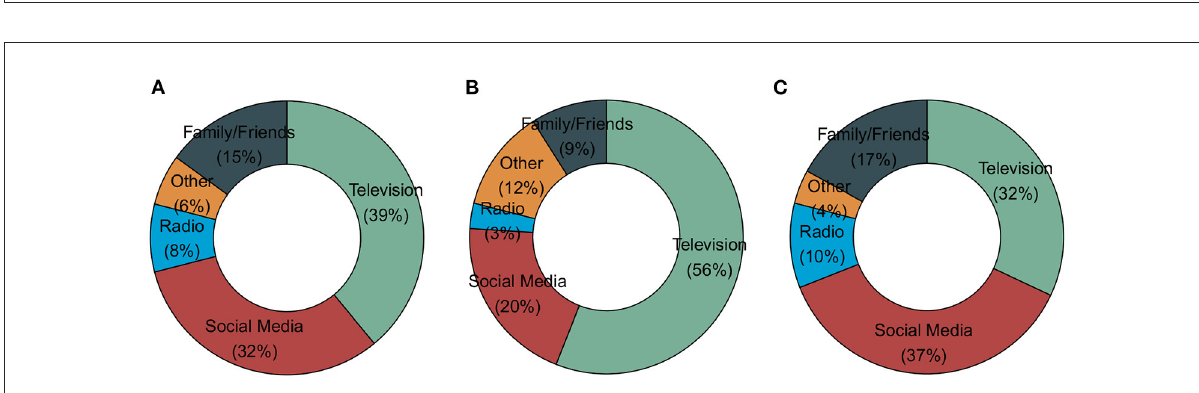
FIGURE2 COVID-19 information source. (A) Combined region information source. (B) Central Arizona information source. (C) Southern Arizona information